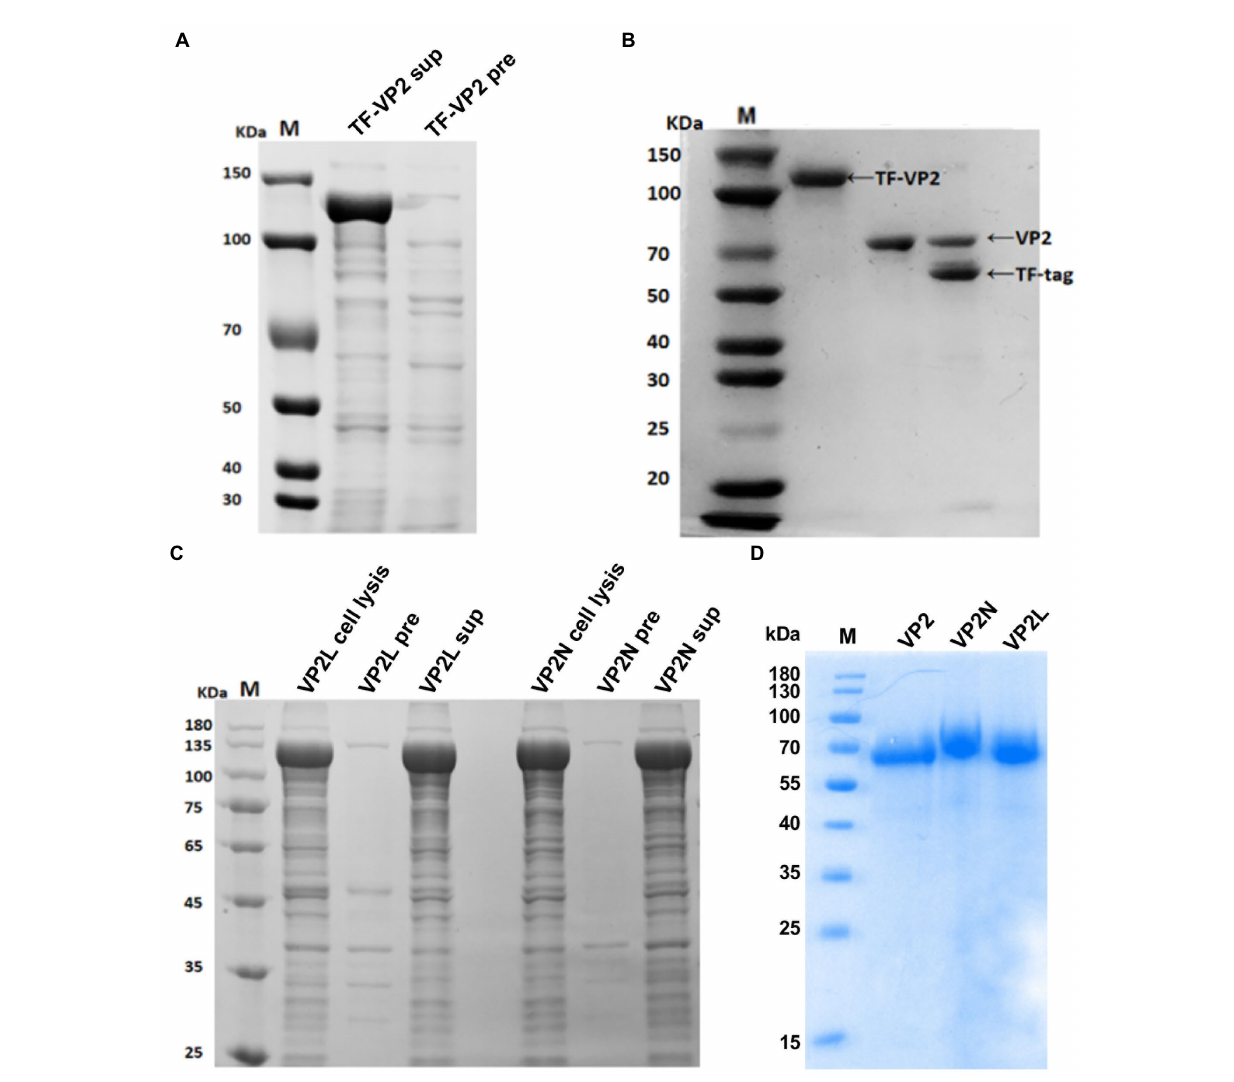
FIGURE 2 Expression and purification analysis of the recombinant protein of CPV VP2/VP2N/VP2L from E. coli by SDS-PAGE. (A) Expression of TF-VP2. Lane 1, TF- VP2 from supernatant (TF-VP2 sup); Lane 2, result from precipitate (TF-VP2 pre). (B) Enzyme digestion of TF-VP2 with Thrombin. Lane 1, TF-VP2 before digestion; Lane 2, VP2 protein after digestion and purification; Lane 3, TF-VP2 digested by Thrombin enzyme. (C) The soluble analysis of TF-VP2N/VP2L. Lane 1, pColdTF-VP2L whole cell (VP2L cell lysis); Lane 2, pColdTF-VP2L precipitate (VP2L pre); Lane 3, pColdTF-VP2L supernatant (VP2L sup); Lane